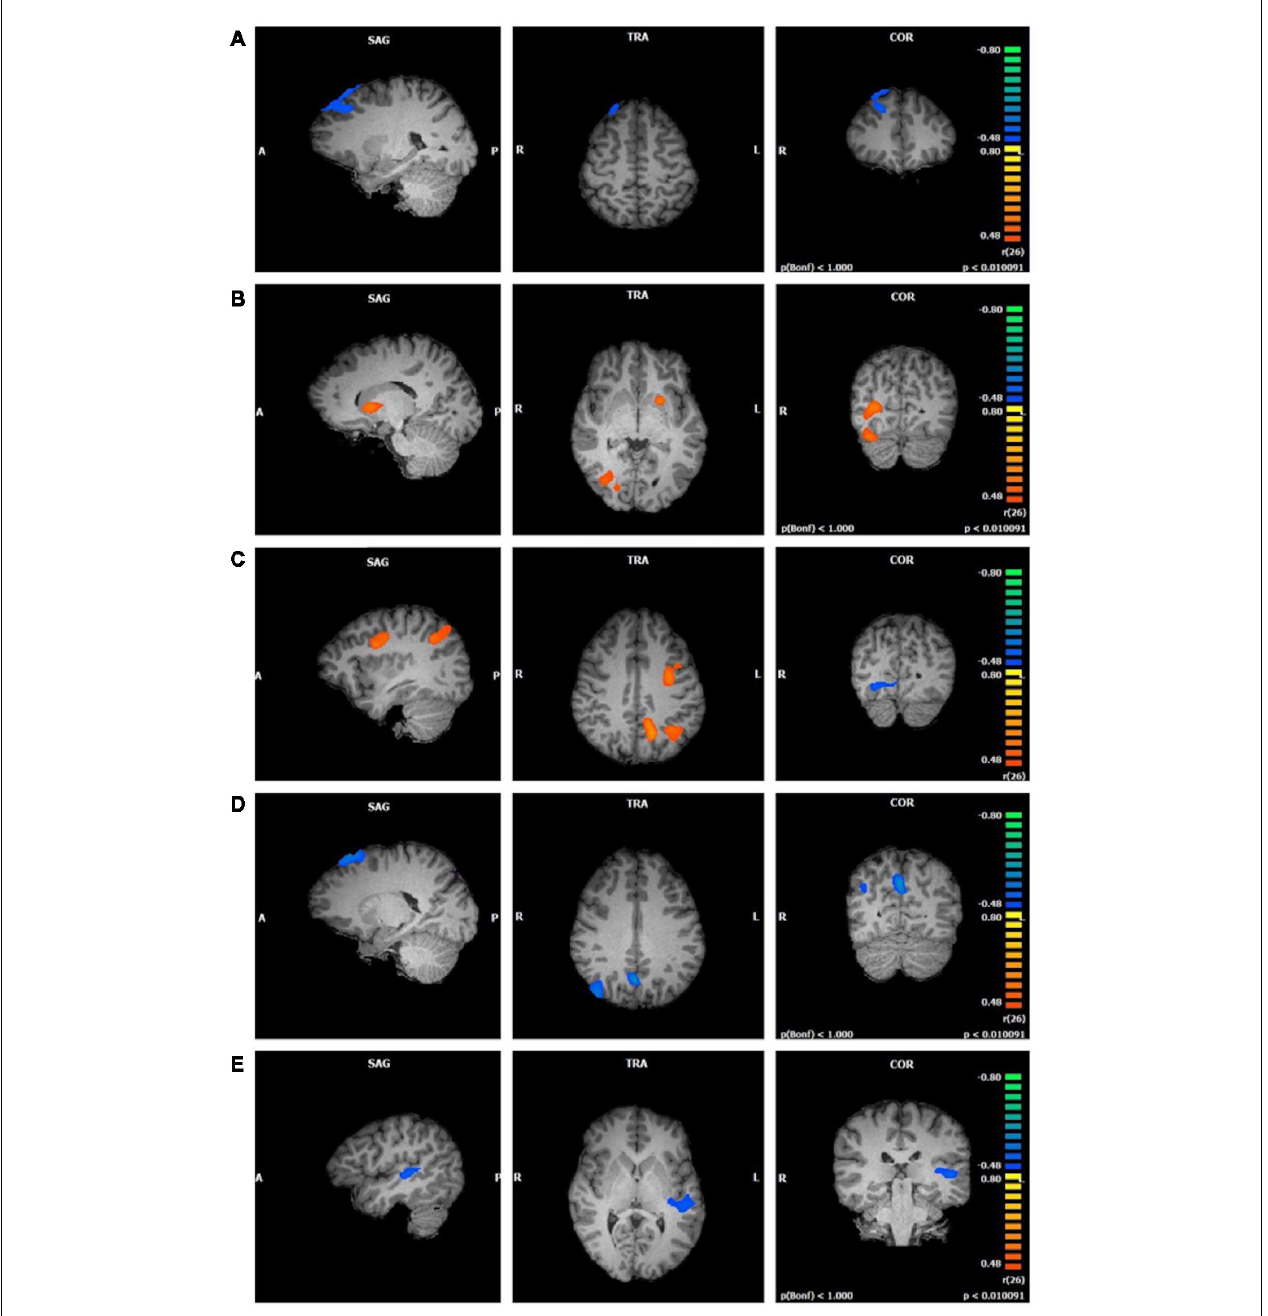
FIGURE 3 | Functional connectivity of central executive network (CEN) clusters correlated with trait mindfulness and four of its facets ( p < 0.01, cluster threshold estimator corrected). From top to bottom: (A) FFMQ Total ; (B) Observing ; (C) Describing ; (D) Acting ; (E) Non-Reactivity